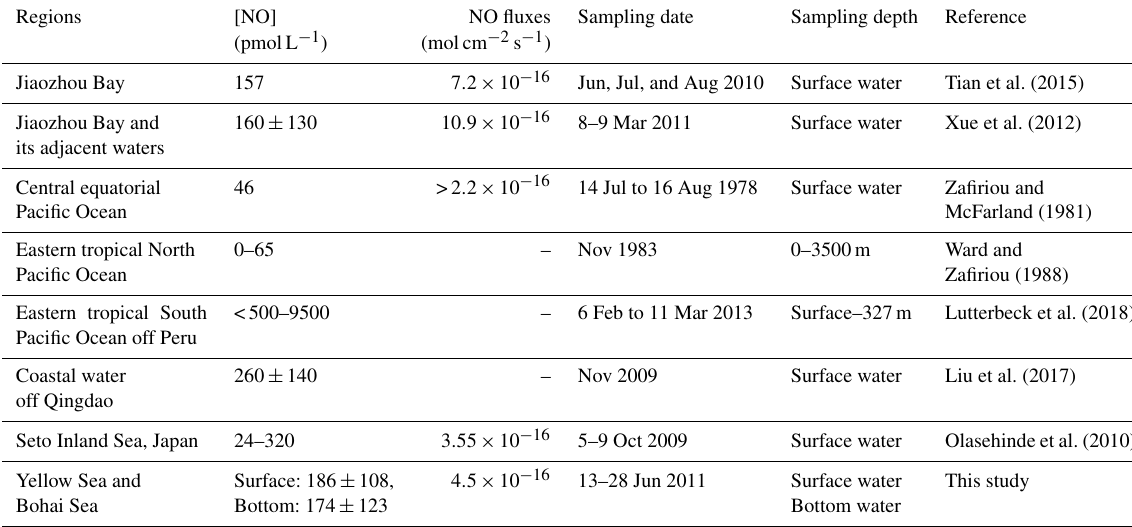
Table 3. NO concentrations and flux densities from different